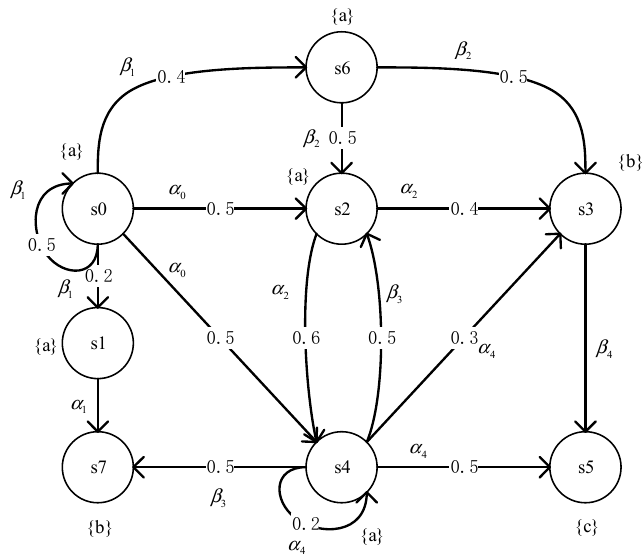
Figure 3. A Markov decision process.